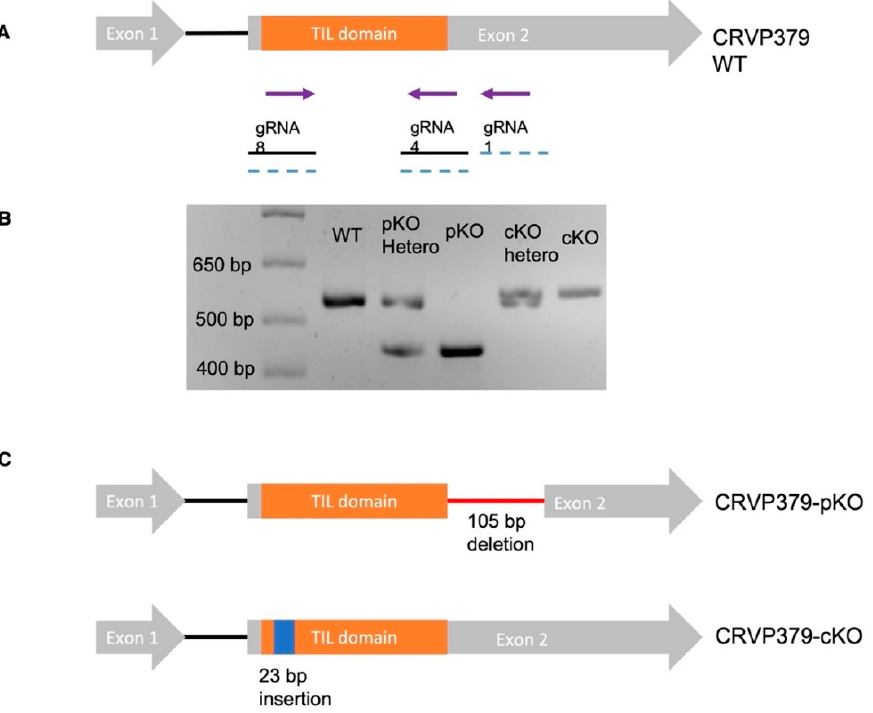
Figure 4. Schematic representation of CRISPR-Cas9-mediated knockout of CRVP379. ( A ) Guide RNAs used for embryo injection; guide RNAs highlighted with a dashed blue line were used together for injection 1; guide RNAs highlighted with a solid black line were used together for injection 2. ( B ) Agarose gel electrophoresis of PCR products of the CRVP379 gene with the CRVP Seq F/R primer set, from left to right: molecular weight ladder, wild type Liverpool, CRVP-pKO heterozygous, CRVP-pKO homozygous (105-bp deletion), CRVP-cKO heterozygous, CRVP-cKO homozygous (23-bp insertion). ( C ) Schematic representation of CRVP-pKO and CRVP-cKo mutations.